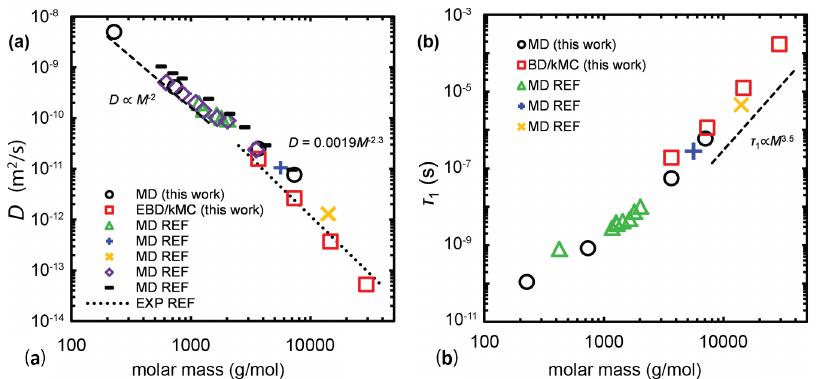
Figure 15. ( a ) Dependence of the self-diffusion coefficient D and the longest relaxation time τ 1 (obtained from the autocorrelation function of the end-to-end vector) on molar mass, from this work (MD, circles; BD/kMC, red squares) [204], as well as ( b ) from various simulation works in the literature (green triangles [109], blue crosses [206], orange X-markers [207], black dashes [76], purple diamonds [27]). The dotted line is a fit on the experimental data performed by Lodge performed by Lodge [39] while the dashed lines are guides to the eye. Reprinted from [204] with permission from